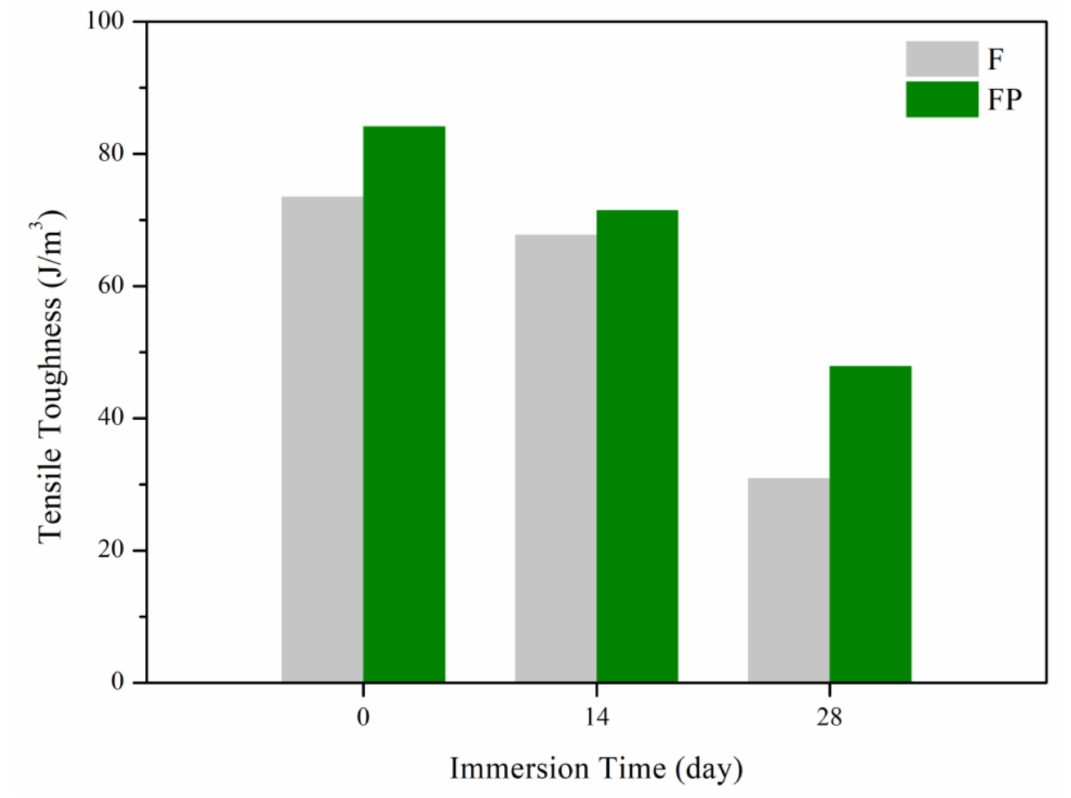
Figure 15. Tensile toughness of F and FP before and after immersed in SBF.